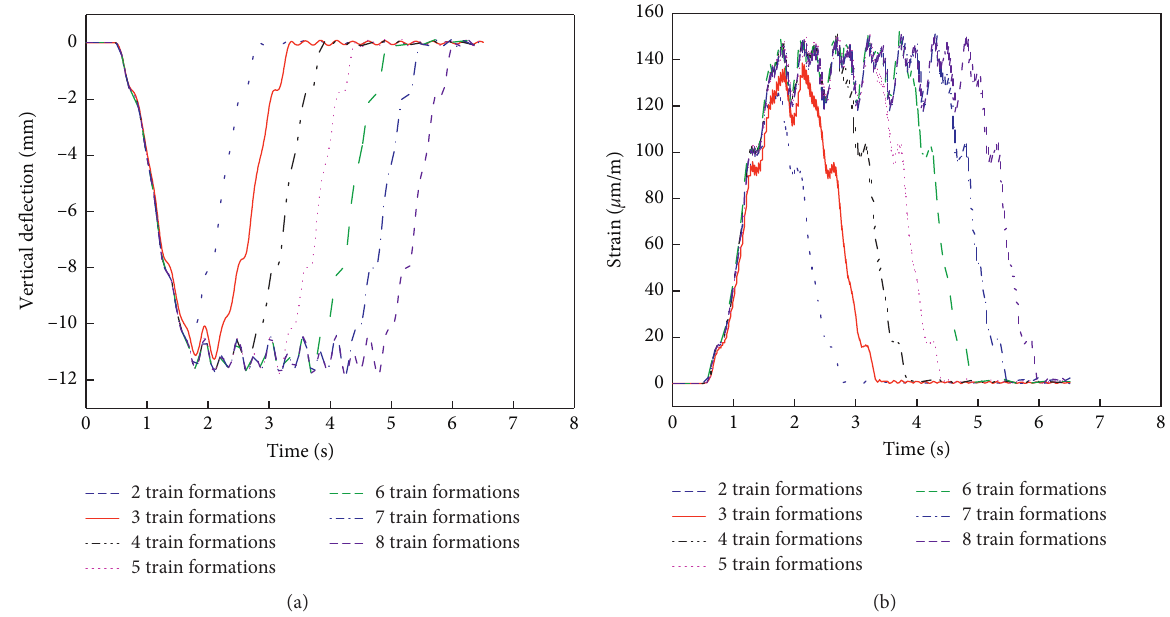
Figure 14: Time histories for the DR of the bridge girders’ mid-span section: (a) vertical deflection; (b) strain.